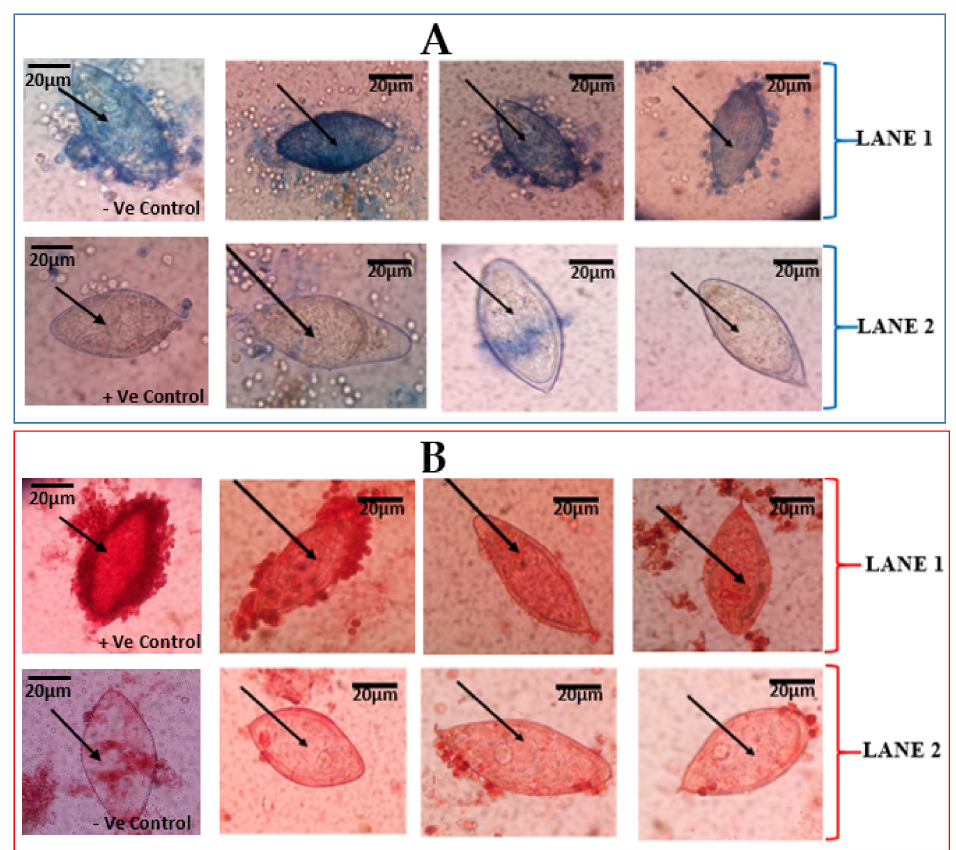
Figure 1. Vital staining of Schistosoma haematobium eggs from urine of school children. ( A ) S. haematobium eggs stained by 0.4% trypan blue observed at × 40 Objective lens: ( A ) LANE 1 shows eggs that retained the 0.4% trypan blue, indicative of dead S. haematobium eggs. LANE 2 shows eggs that did not retain of 0.4% trypan blue stain, indicative of live eggs. The first slides of LANES 1 and 2 show –Ve (negative) and + Ve (positive) controls, respectively. ( B ) S. haematobium eggs stained with 1% neutral red and observed at × 40 Objective lens. LANE 1 shows eggs with retention of 1% neutral red, indicative of live eggs of S. haematobium . LANE 2 shows eggs with non-retention of 1% neutral red stain, indicative of dead eggs. The first slides of LANES 1 and 2 show + Ve (positive) and -Ve (negative) controls,